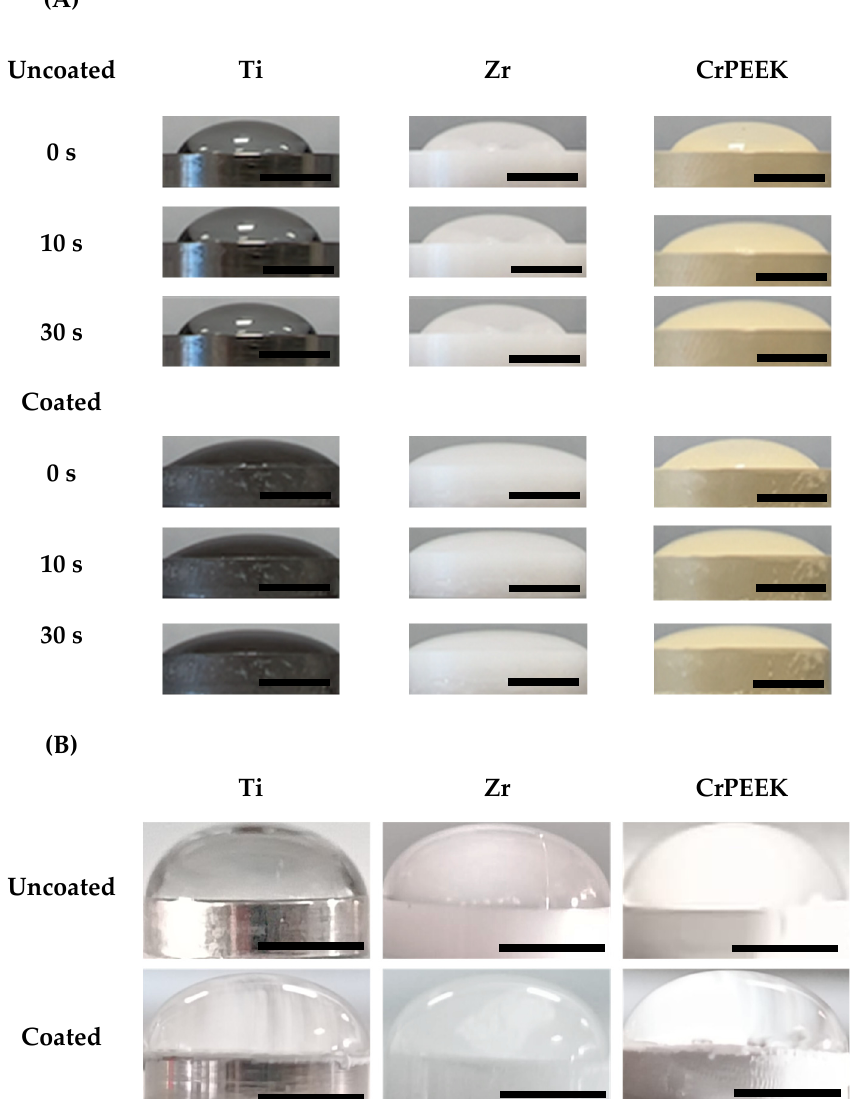
Figure 3. Contact angle behaviour of specimens. ( A ) Hydrophilic (water) measurement at different time points, 0, 10, and 30 s, and ( B ) hydrophobic (glycerol) at 30 s, respectively. Scale bar: 0.4 cm.